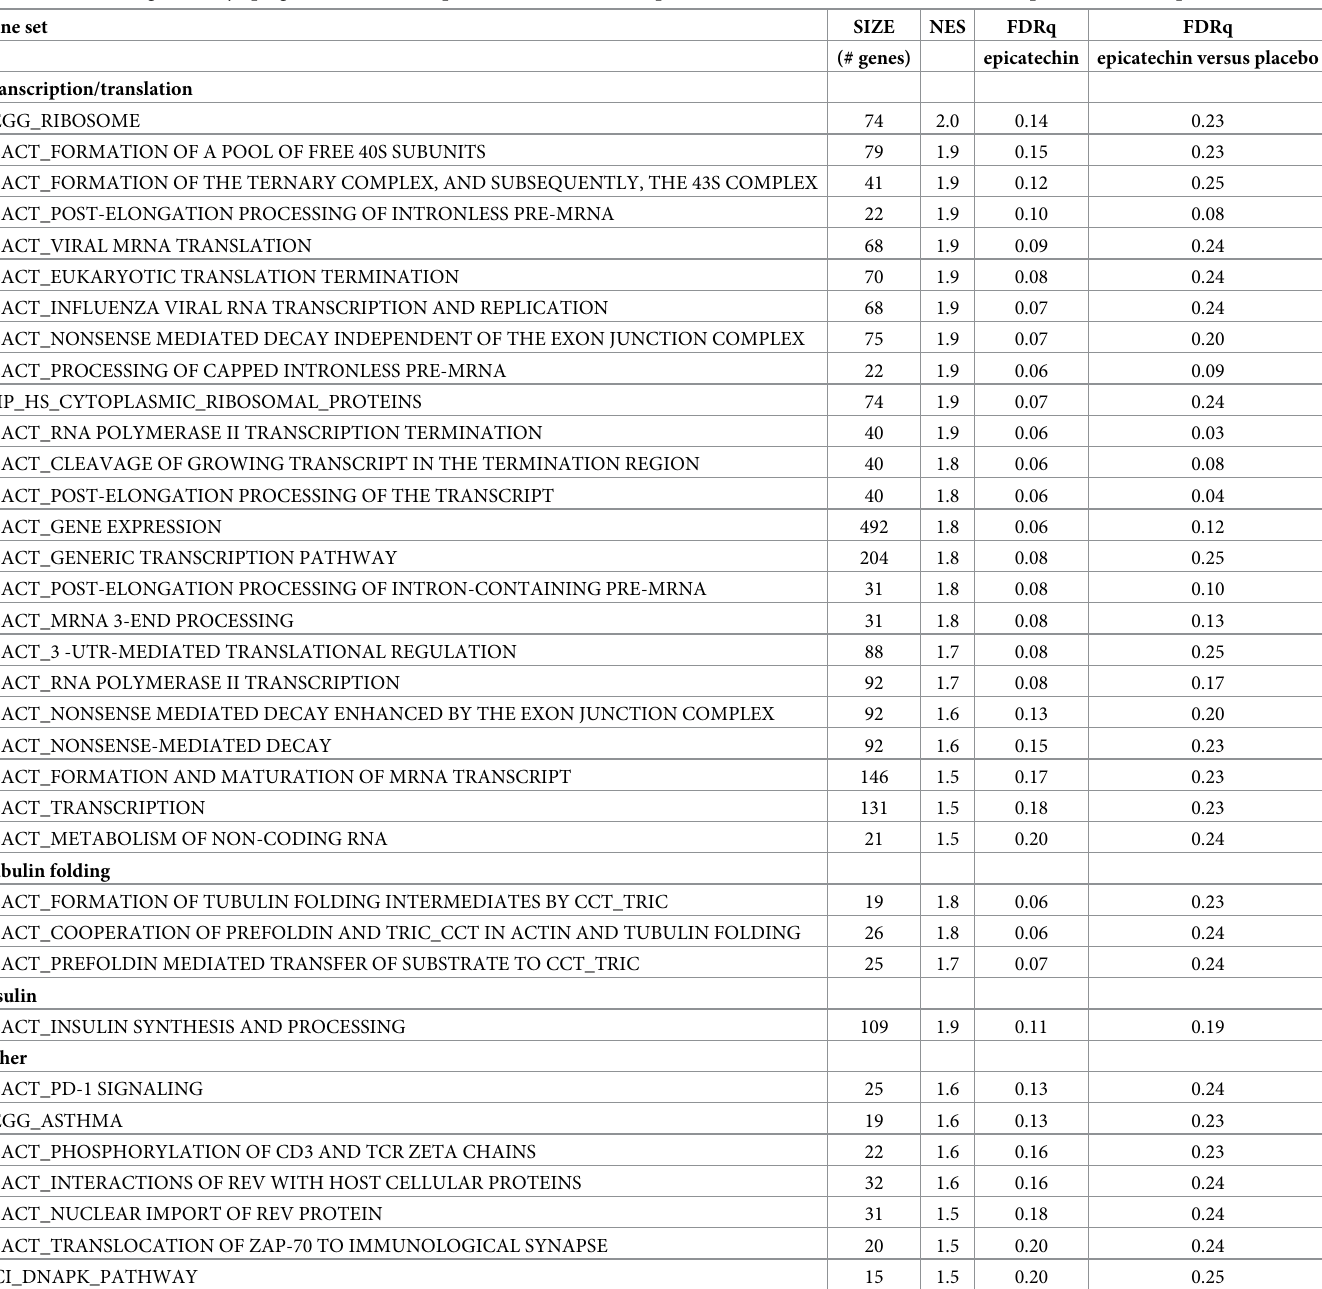
Table 3. Gene sets significantly upregulated within the epicatechin intervention (epicatechin) and between intervention arms (epicatechin versus placebo). Gene set